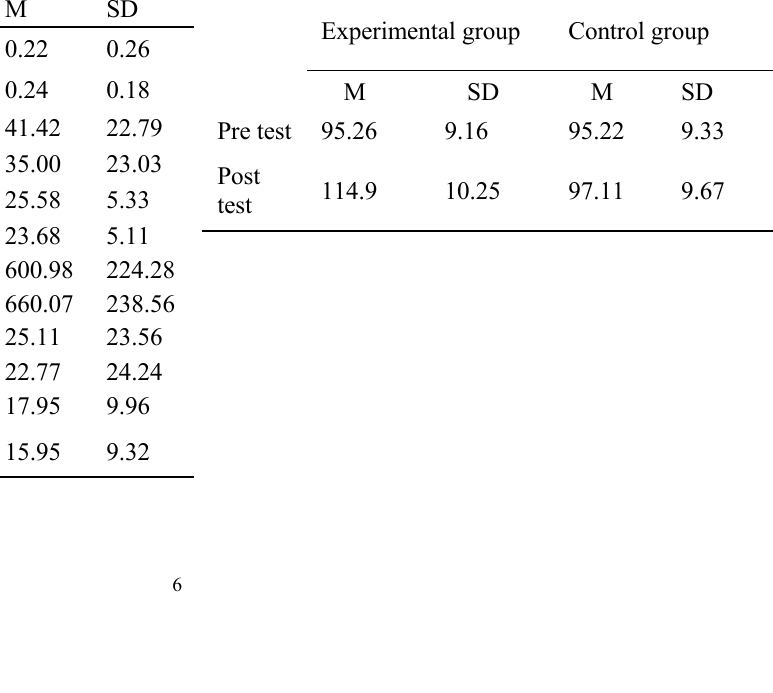
Table 3. Mean and standard deviations of visual-motor skills in pretest and posttest.